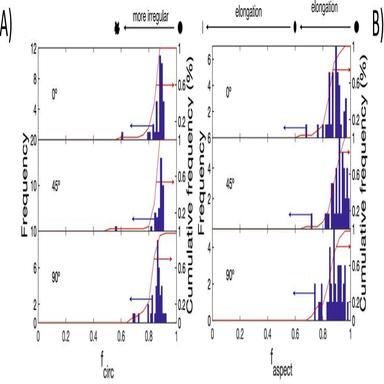
Histograms and cumulative frequencies of circularity A) and aspect ratio B) of the pores in the 0◦, 45◦ and 90◦ samples. These shape descriptors are defined in equations and 3), respectively.